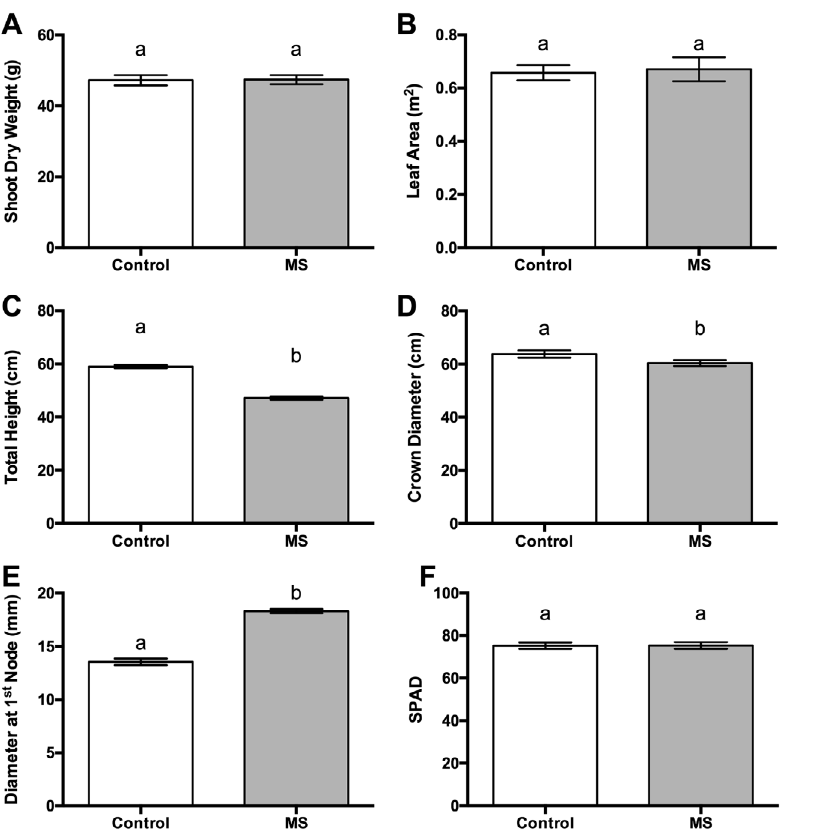
Figure 4: Vegetative shoot metrics for control and mechanically stimulated pepper plants during the fruit set and maturation study: (A) Shoot dry mass; (B) Leaf area; (C) Total height; (D) Crown diameter; (E) Stem diameter at the first node; (F) Relative chlorophyll level (SPAD). Columns with the same letter appearing above do not differ at p≤0.05. Error bars are SEM.